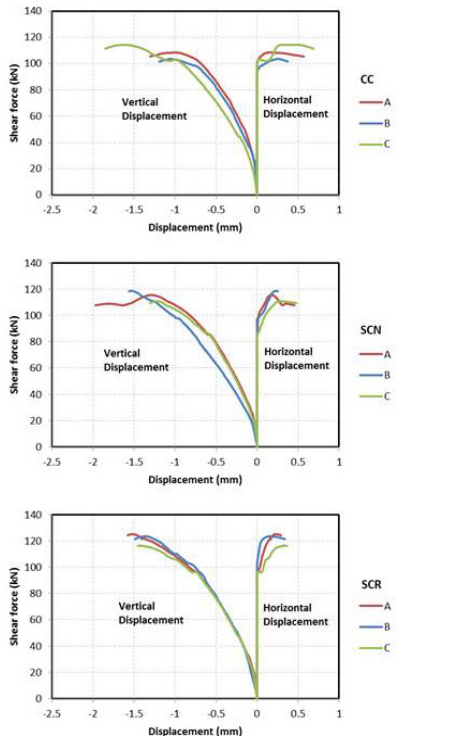
Figure 4. Shear plane displacements measured during